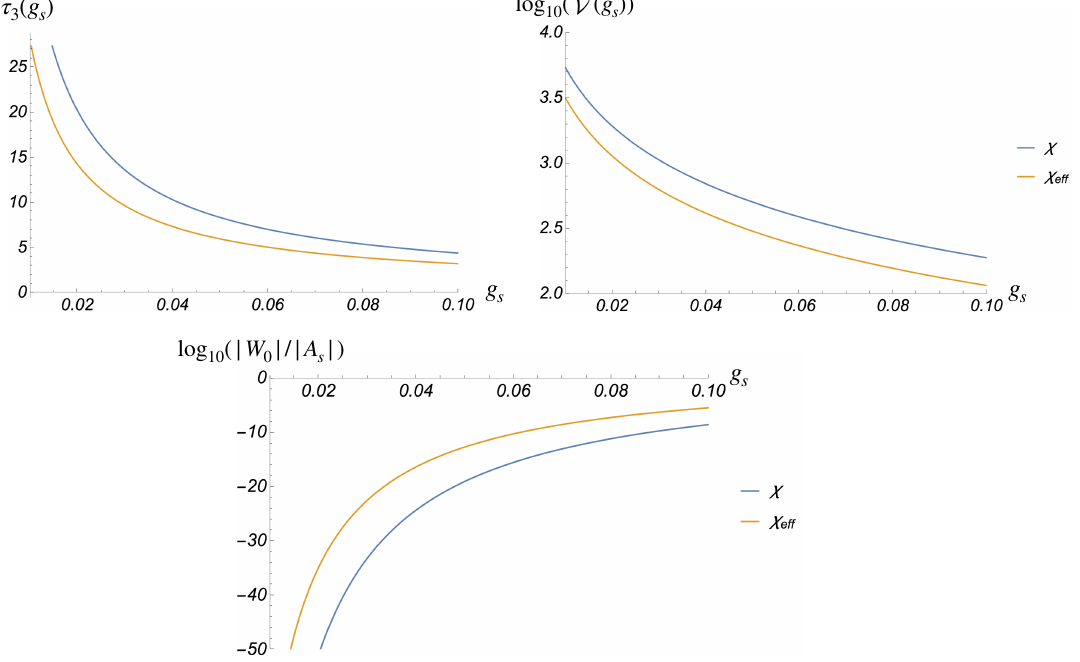
Figure 9 . Values for τ s , V and | W 0 | / | A s | for Minkowski minima for the full and effective Euler